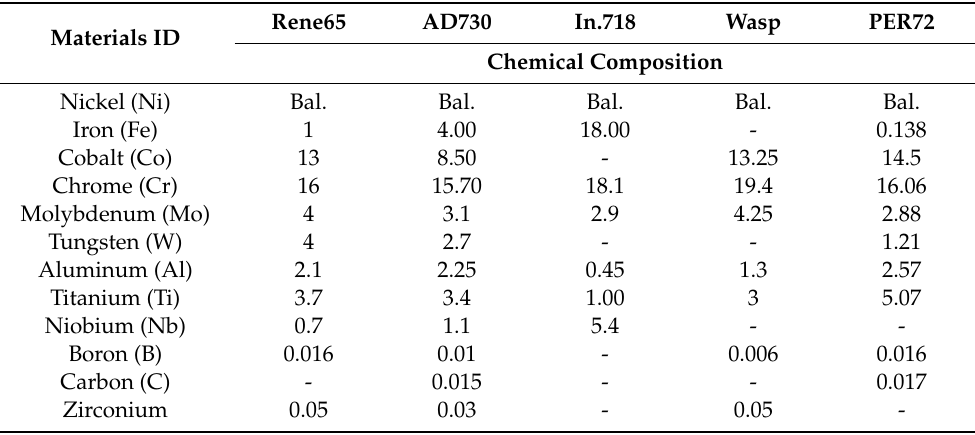
Table 1. Ni-based alloy materials with composition (wt.%) adapted from